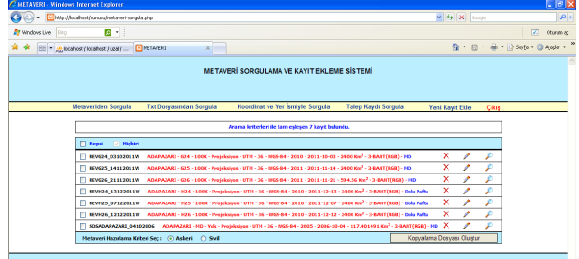
Figure 2. Metadata search and record addition system interface